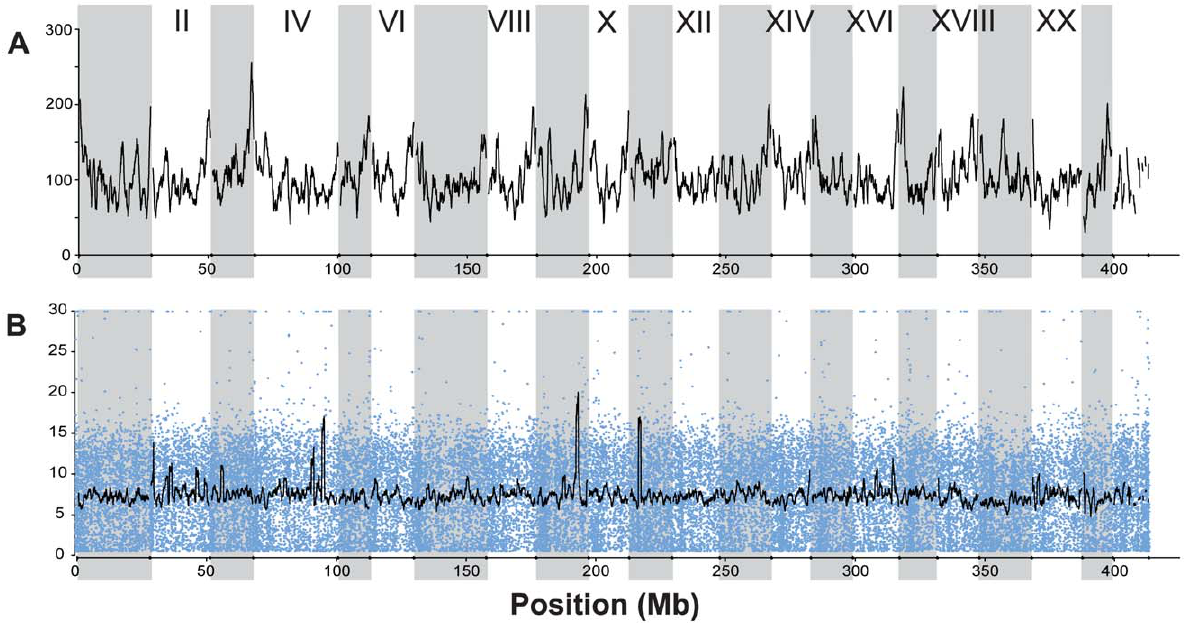
Figure 3. Depth of RAD sequencing coverage. (A) Number of RAD tags sequenced per 1-Mb sliding window across the genome. Each RAD tag represents either 30 or 47 bp of sequence data (see Table S1). Vertical gray shading indicates Linkage Groups I through XXI, followed by all unassembled scaffolds greater than 1 Mb in length. Not all RAD tags were sequenced in all individuals, because of both random sampling in the sequencing process and polymorphism in the restriction enzyme recognition site. (B) Sequencing depth per RAD tag per individual from one sample run (22 May 2009, lane 7; see Table S1). Blue dots represent the average number of reads per individual across 16 individuals sampled for each RAD tag. The black line shows the mean depth per individual in a 1-Mb sliding window. A total of 5,597,895 barcoded and aligned sequence reads from 16 individuals were generated from this run.